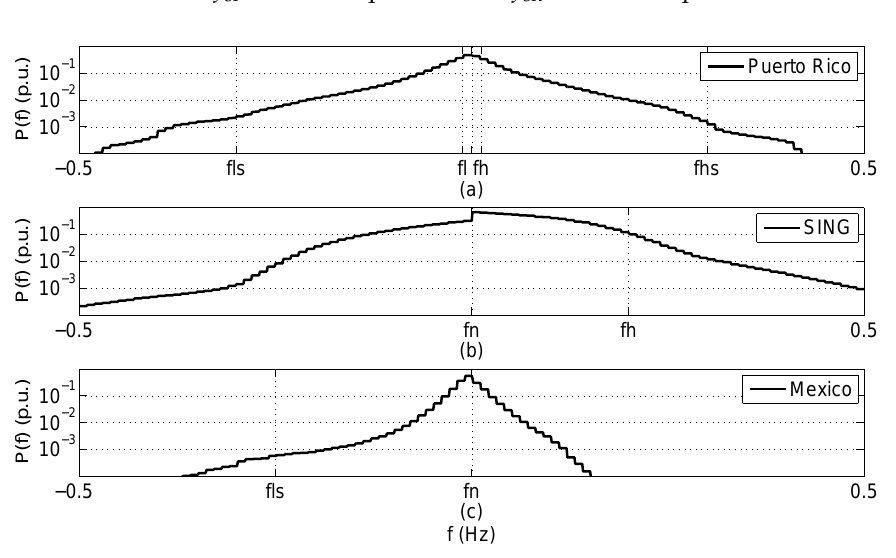
Figure 6. Occurrence probability of a frequency excursion in three different power grids: ( a ) Puerto Rico (PREPA); ( b ) Chile (SING); and ( c ) Mexico